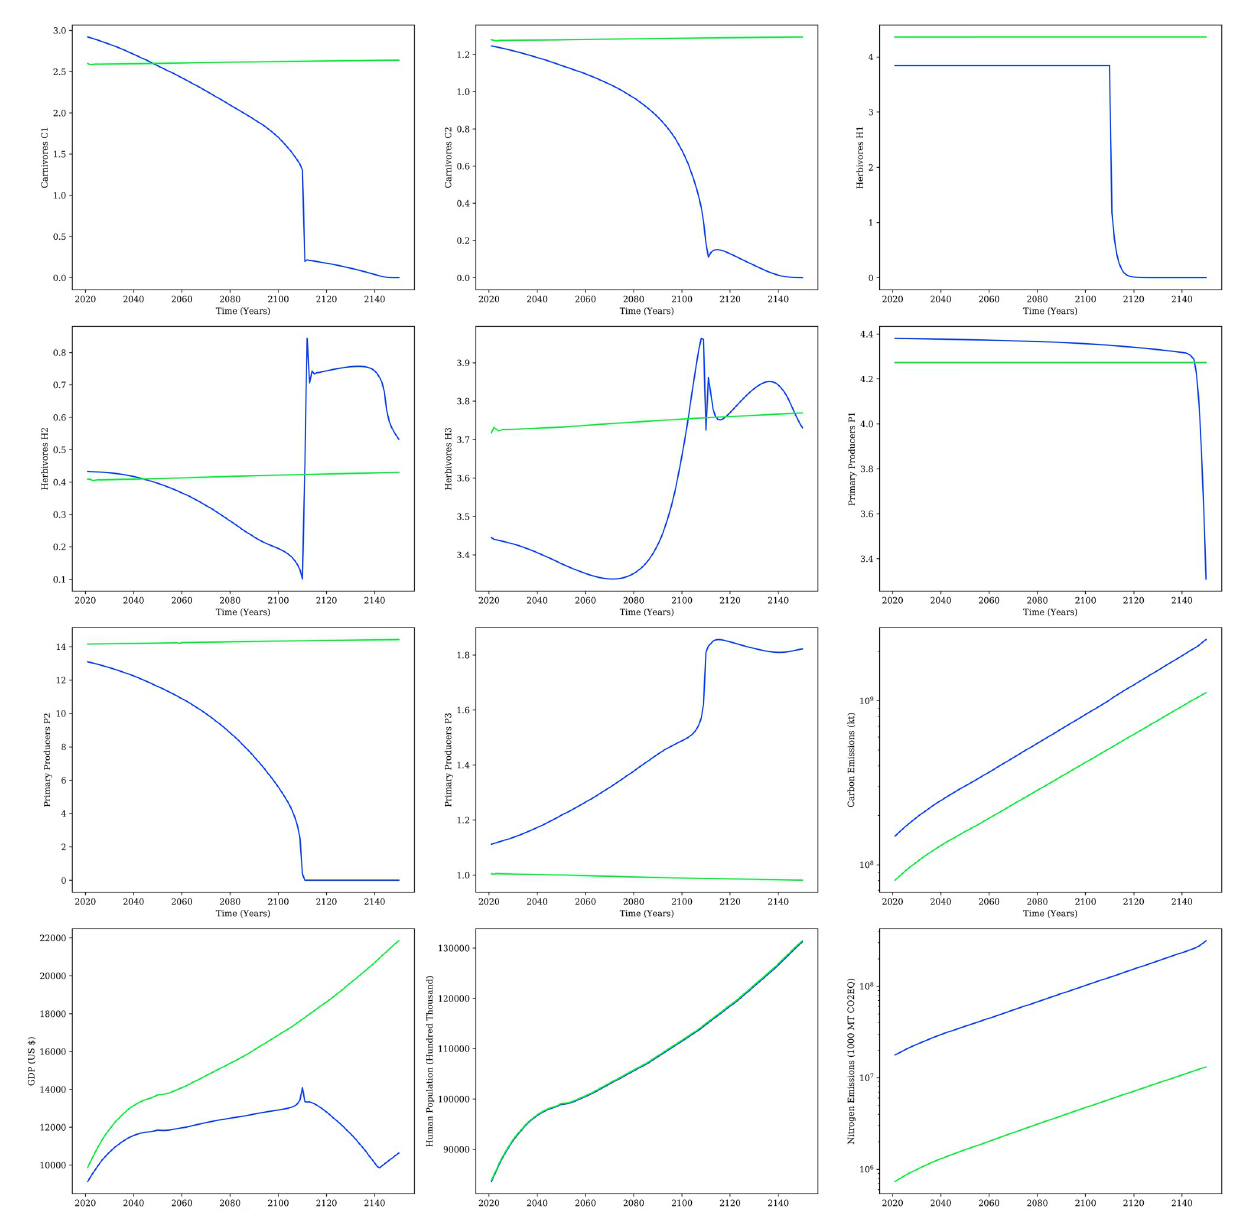
Fig 11. Preliminary results. Comparison of all compartments for the controlled per capita consumption increase scenario (scenario 3—controlled shown in green) to the uncontrolled per capita consumption increase scenario (scenario 3 shown in